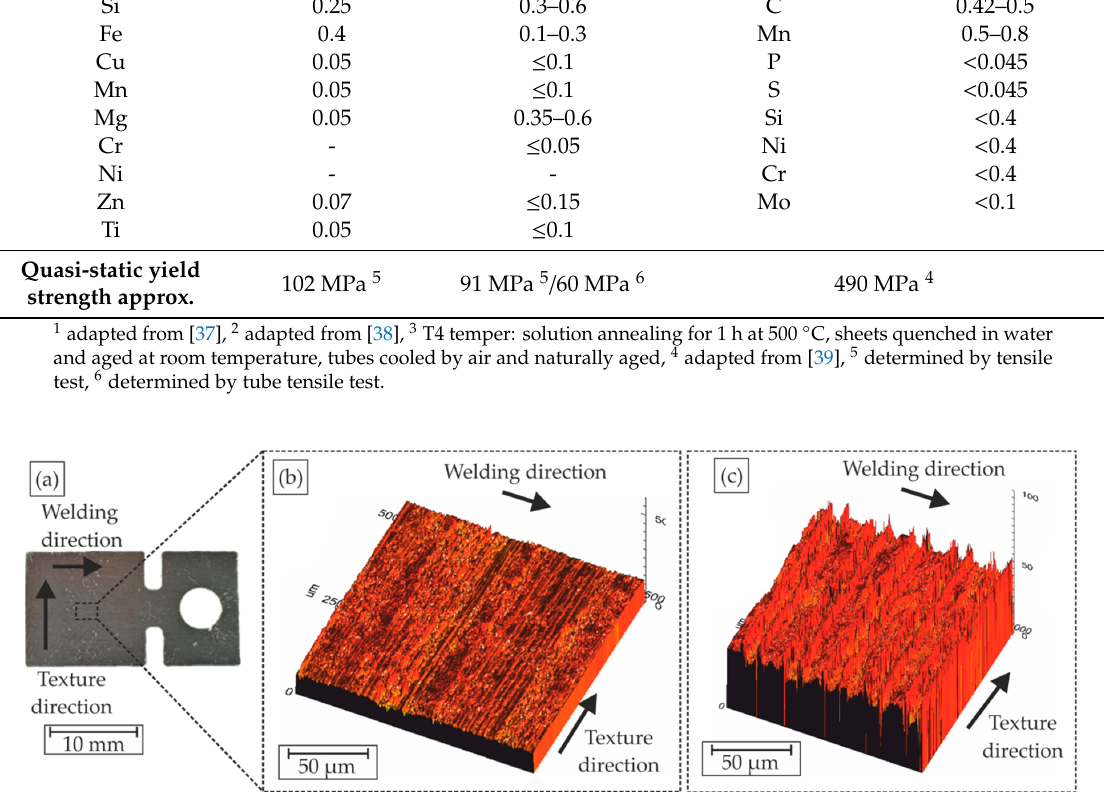
Figure 3. ( a ) Texture and welding directions at the specimen and detailed surface structures after ( b ) laser ablation and ( c ) laser structuring. Table 3. Composition and quasi ‐ static yield strength of aluminum EN AW ‐ 1050 alloy, EN AW ‐ 6060 alloy, and C45.